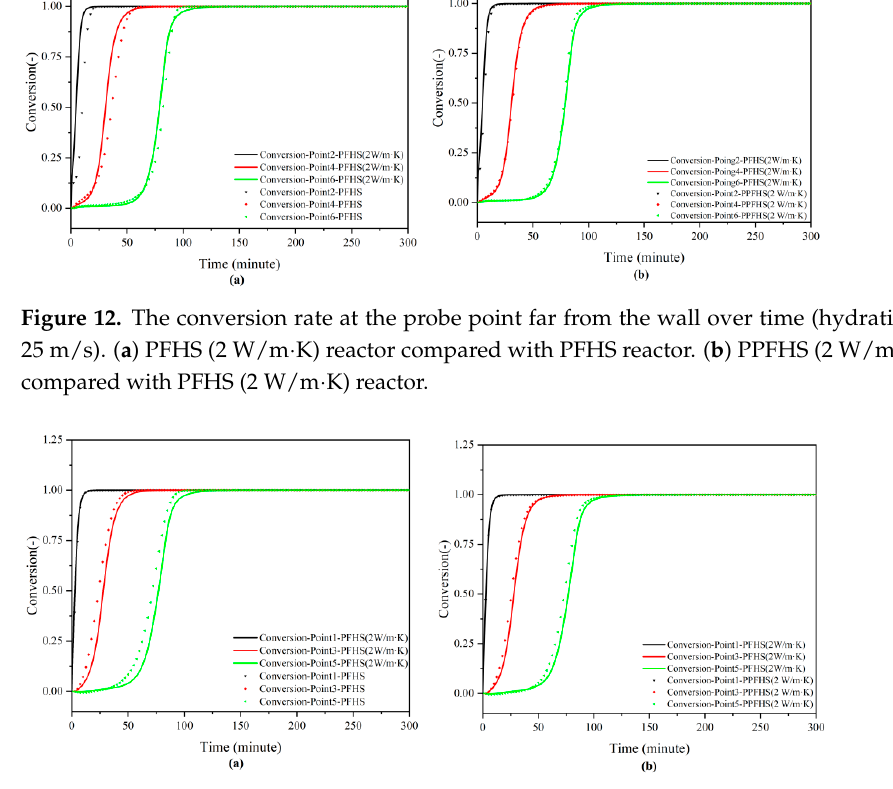
Figure 13. The conversion rate at the probe point near the wall over time (hydration, ε = 0.5, 25 m/s). ( a ) PFHS (2 W/m·K) reactor compared with PFHS reactor. ( b ) PPFHS (2 W/m·K) reactor compared with PFHS (2W/m·K) reactor.